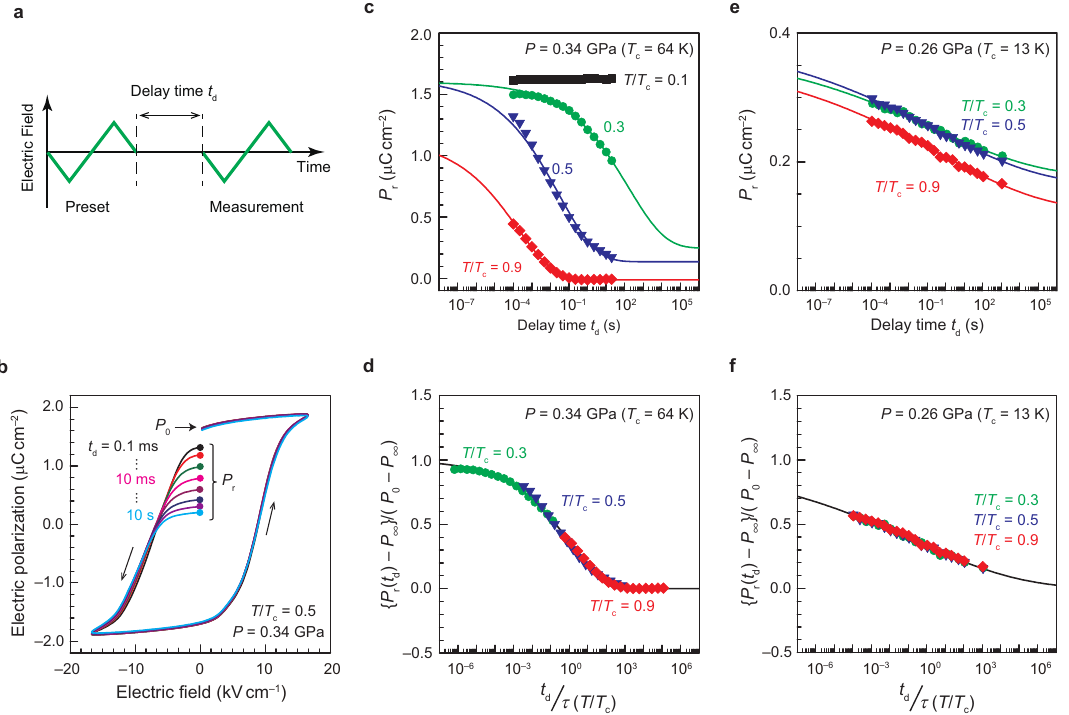
Figure 5. ( a ) Measurement protocol for probing the polarization decay. ( b ) Typical polarization hysteresis loops with various delay times, measured at 0.34 GPa and T / T c = 0.5. ( c ) Delay-time dependences of the remnant polarization at select temperatures and 0.34 GPa ( T c ≈ 64 K). ( d ) Normalized relaxation behavior of the polarization decay at 0.34 GPa. ( e ) Delay-time dependence of the remnant polarization at 0.26 GPa ( T c ≈ 13 K), which is near the ferroelectric QCP. ( f ) Normalized relaxation behavior of the polarization decay at 0.26 GPa. The lines in ( c – f ) represent fits to the standard relaxation equation; see Equation